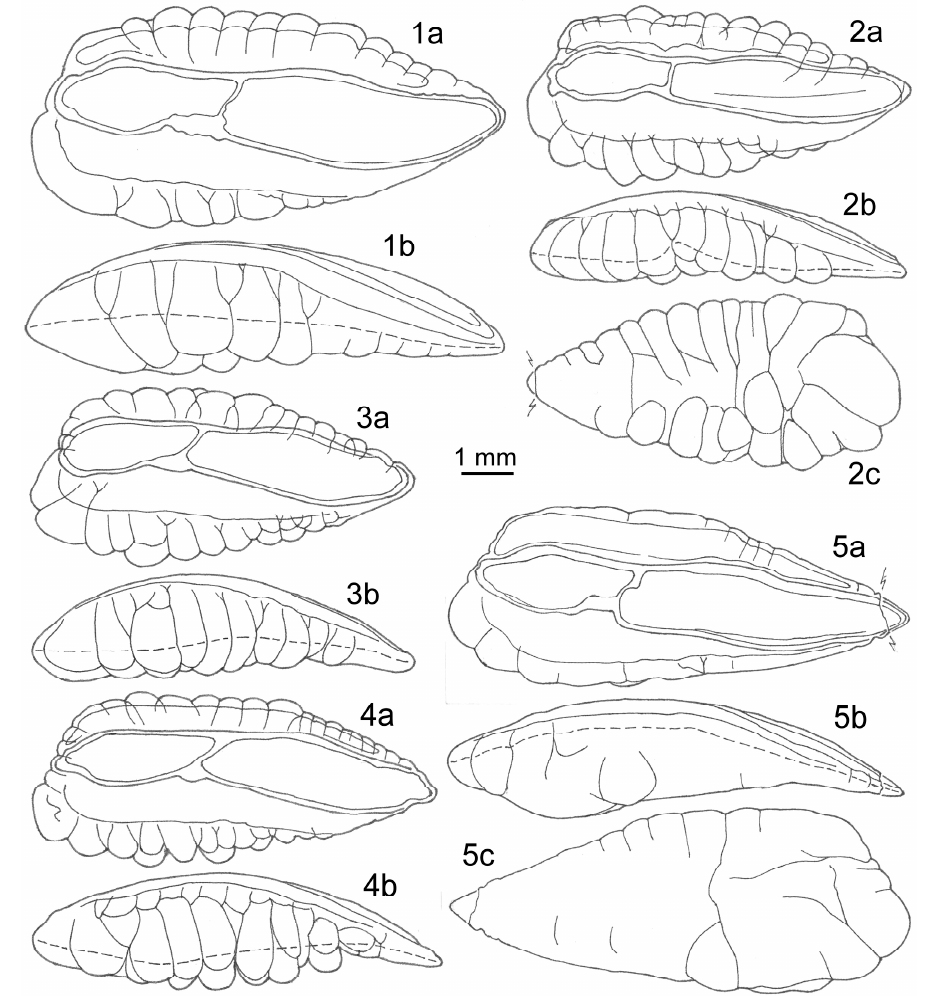
Figure 10. Trisopterus luscus otoliths from Greece and the North Sea, and (most likely) Trisopterus capelanus otolith, Faroe Islands. ( 10.1a , b , 10.2a – c ) T. luscus , Ovvoïkós Channel, east of mainland of Greece, below 100 m depth, mirror images; 10.1a , b . female, TL 245, OL 9.21; ( 10.2a – c ) female, TL 149, OL 7.28; ( 10.3a , b , 4a , b ) T. luscus , North Sea, coll. M. Leopold, numbers AR 32 and AR 31, respectively; ( 10.3a , b ) TL 166, OL 7.34; ( 10.4a , b ) TL 163, OL 7.74; ( 10.5a – c ) Most probably T. capelanus , Faroe Bank, Faroe Islands, cruise 03680025, number 5092, male, TL 181, TW 55, OL c . 8.45, mirror image.